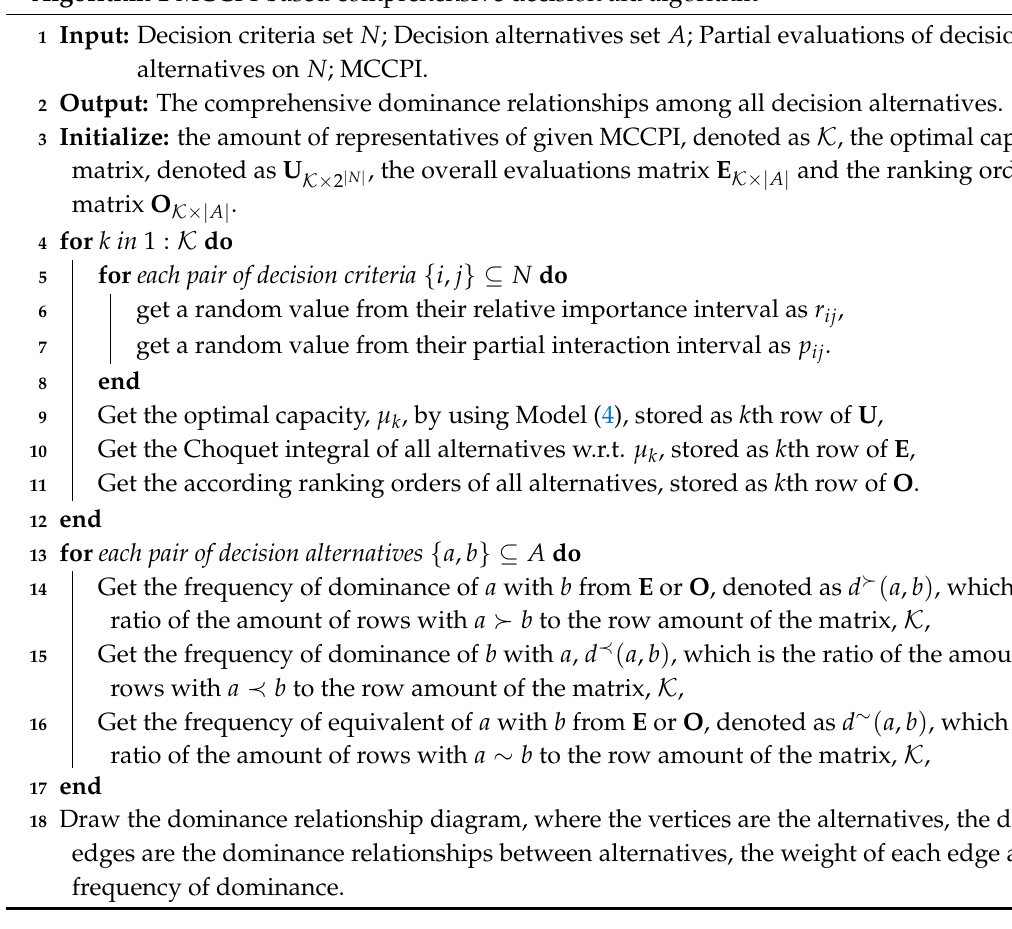
Algorithm 1 MCCPI-based comprehensive decision aid